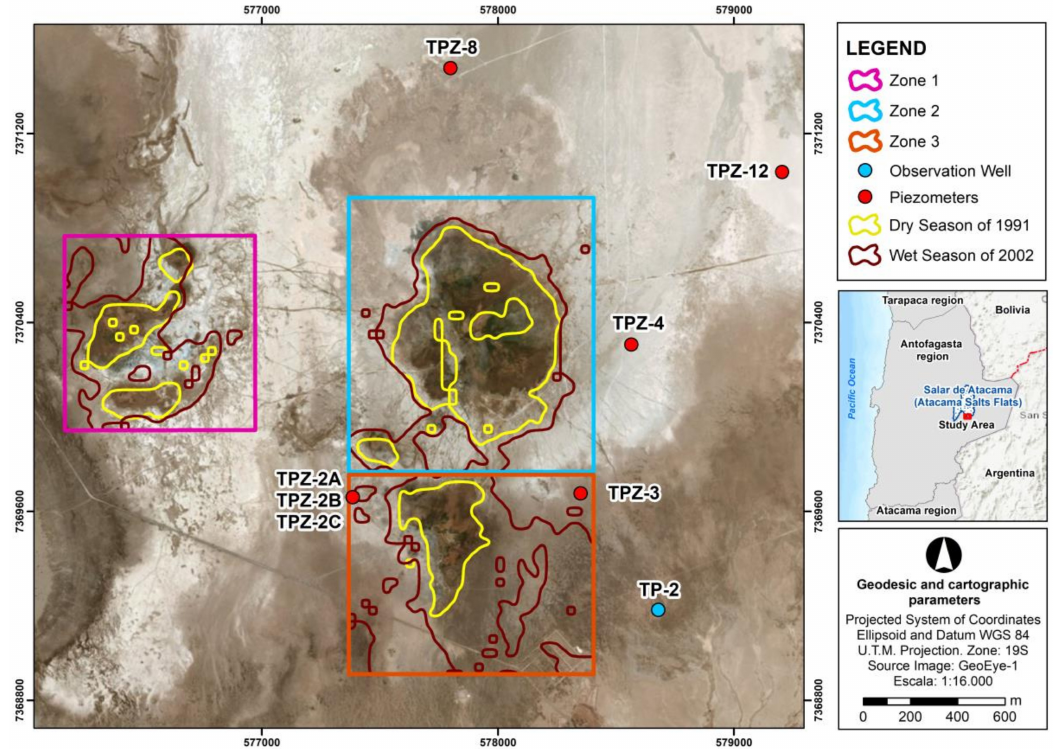
Figure 2. Maximum and minimum extent of vegetation cover in the Tilopozo salt meadows in the period studied.